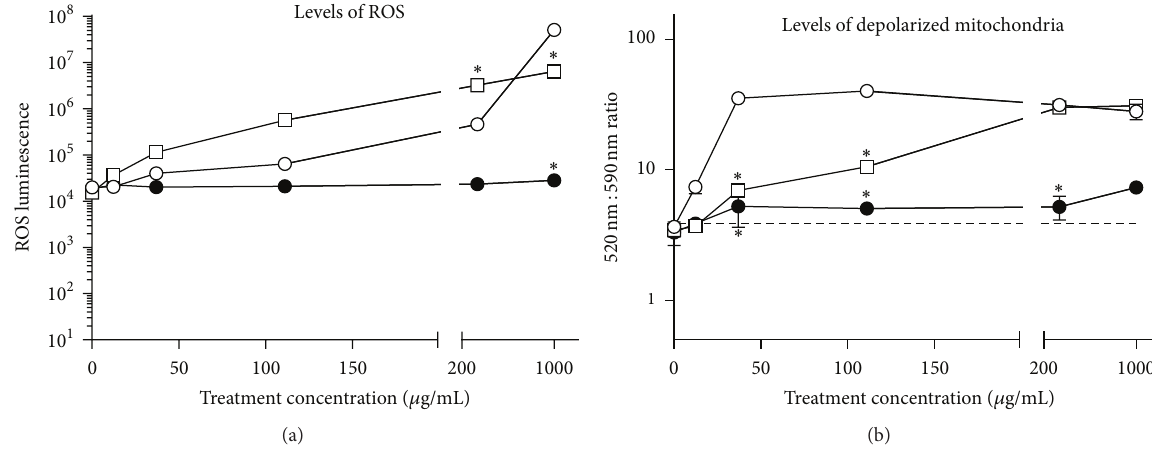
Figure 3: Cellular stress induced by C. zacatechichi is indicated by a surge in ROS and a rapid shift toward MMP loss. HK-2 cells treated for 24 hours with C. zacatechichi (open circles), cisplatin (open squares), or valproic acid (filled circles) were assayed for cellular levels of (a) normalized mean average ROS levels ( ± SEM) as well as (b) changes in the relative amounts of mitochondria that undergo loss versus maintenance of membrane potential, calculated as a mean average ( ± SEM) ratio of fluorescence emission at 520 versus 590 nm. ∗ , cisplatin or valproic acid versus C. zacatechichi , 𝑃 < 0.001